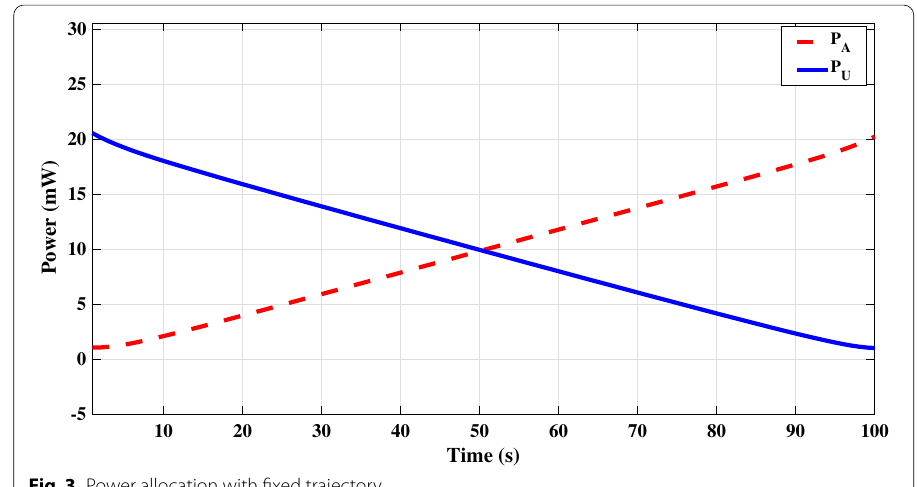
Fig. 3 Power allocation with fixed trajectory